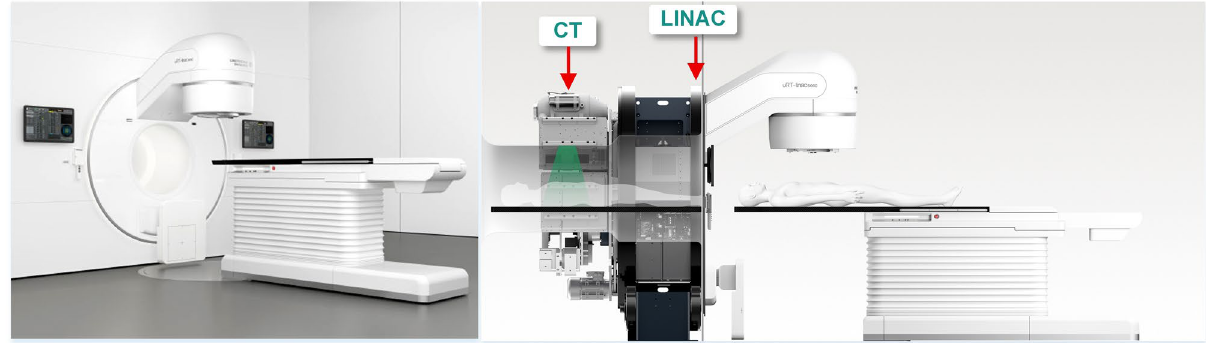
Figure 1. Schematic diagram of uRT-linac 506c linear accelerator (United imaging HealthCare co., LTD., Shanghai) (cited from the commercial brochure with